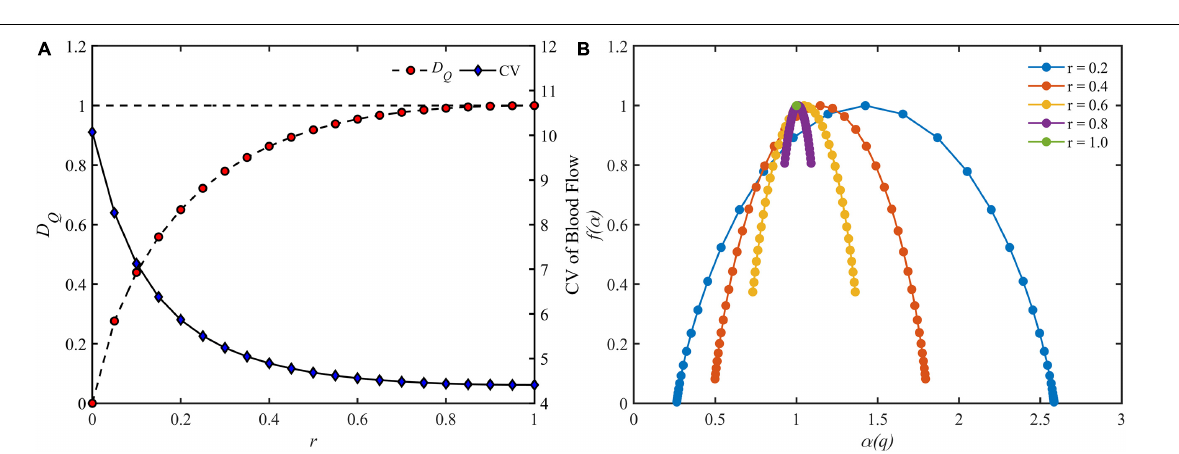
FIGURE 5 | The change of different parameters of the blood flow for different split ratios in a perfect binary vascular tree. (A) The fractal dimension and the coefficient of variation. (B) The multifractal